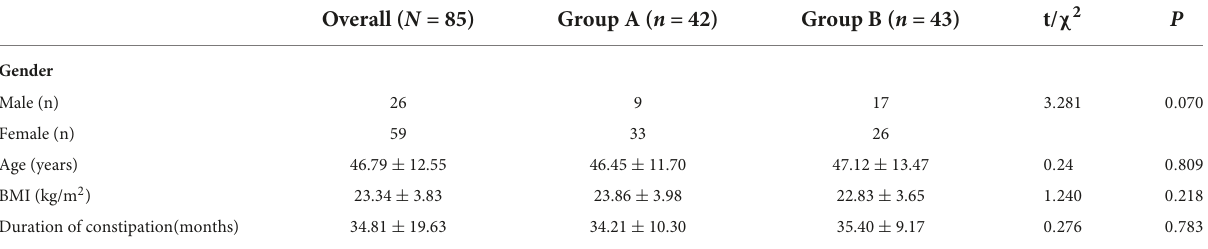
TABLE 1 Demographic characteristics for the two study